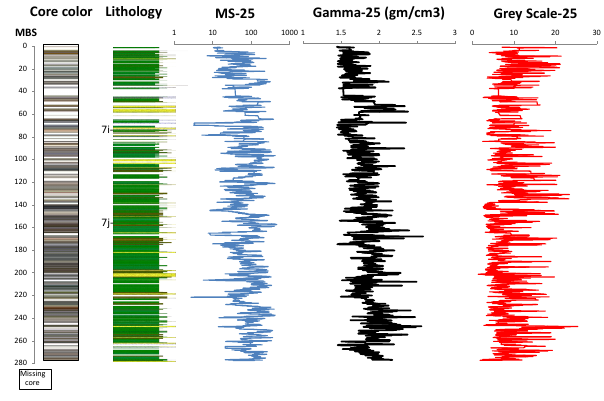
Figure 14. Summary stratigraphy of core HSPDP-CHB14-2A, from the Chew Bahir drilling area, southern Ethiopian Rift Val- ley, based on Initial Core Description results. Note: coring gaps in CHB14-2A are almost entirely infilled by matching to the twinned borehole CHB14-2B (not illustrated), collected immediately adja- cent to this core. Columns from left to right: Core color stratig- raphy; lithologic log; see Fig. 5 for the key to lithologies used in all cores illustrated; composite of magnetic susceptibility (MS) log data (25-point running mean smooth) from LacCore Geotek © XYZ point sensor data; composite of induced gamma density log data (25-point running mean smooth, spurious values <1.4gmcm − 3 re- moved); composite of spectrophotometric grey-scale log data (25- point running mean smooth). All data collection, instrumentation, and parameters as in Fig.